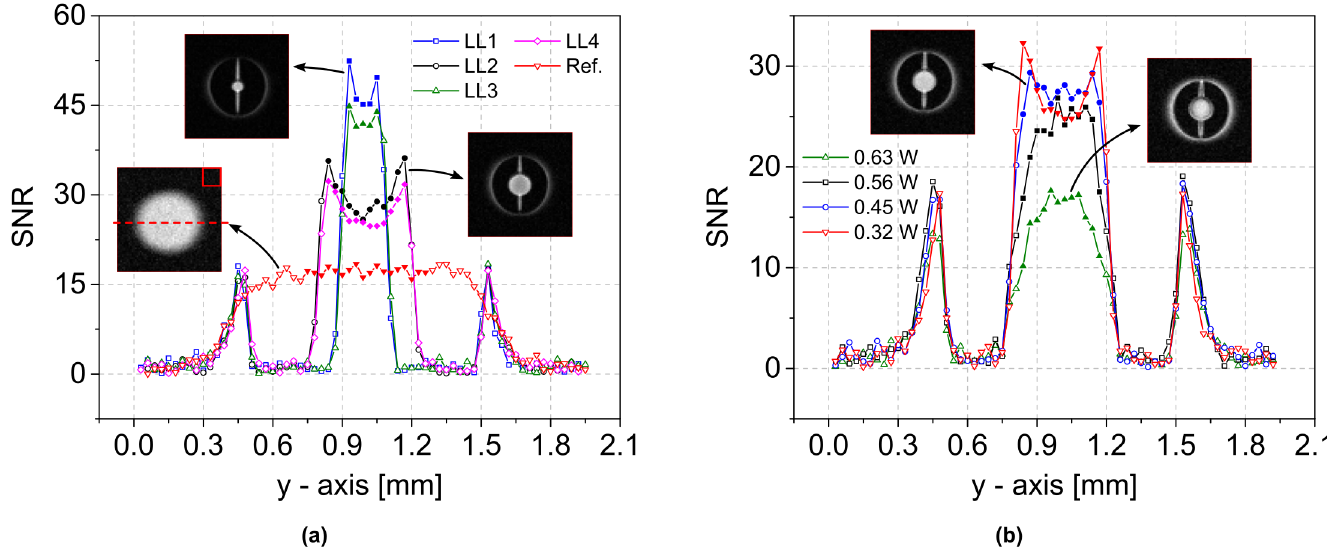
Fig 3. Obtained SNR line profiles from the different designs and at different excitation powers. (a) Extracted SNR line profiles of LL1-LL4and of the reference scan along the y -axis, as exemplified by the broken line in the reference image. All scans were acquired at a globalflip angle of 90˚. The mean noise was calculatedfrom a 12 × 12 pixel matrix in the upper right corner of the same scan, as depicted.Statistics were derived from the regions illustrated by filled symbols. The powers for LL1 to LL4 and the reference scan were 0.18 W, 0.25 W, 0.18 W, 0.32 W and 1 W. (b) SNR profiles of LL4 at globalflip anglesof 90˚, 106˚, 119˚ and 126˚ and corresponding pulse powers of 0.32 W, 0.45 W, 0.56 W and 0.63 W. Statistics were derived from the regions illustrated by filled symbols.